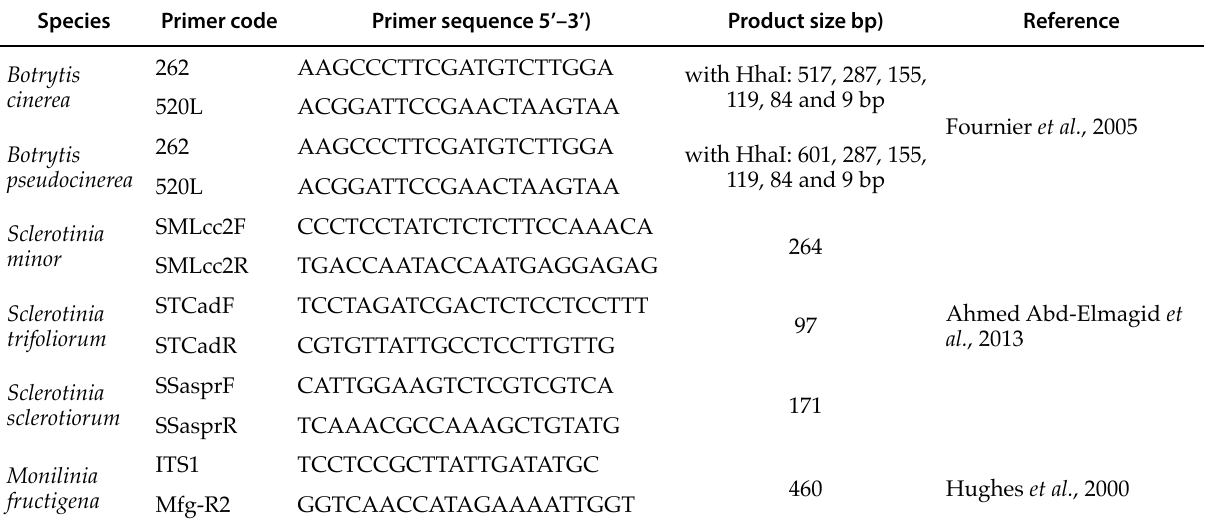
Table 2. Details of the species-specific primers used in this study.